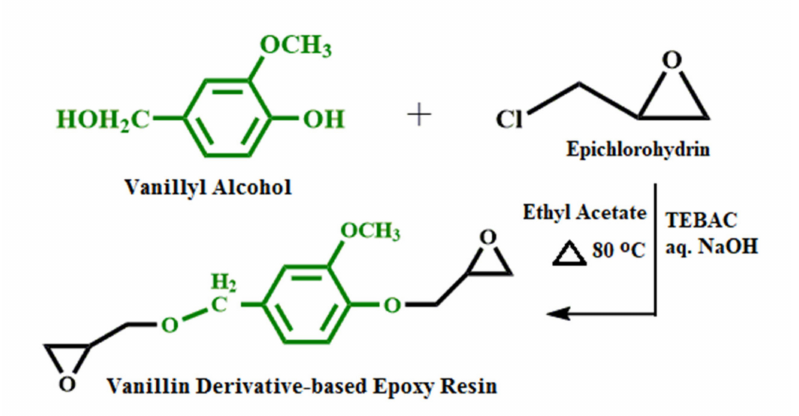
Figure 2. Reaction scheme of vanillyl alcohol–based bioepoxy resin synthesis.